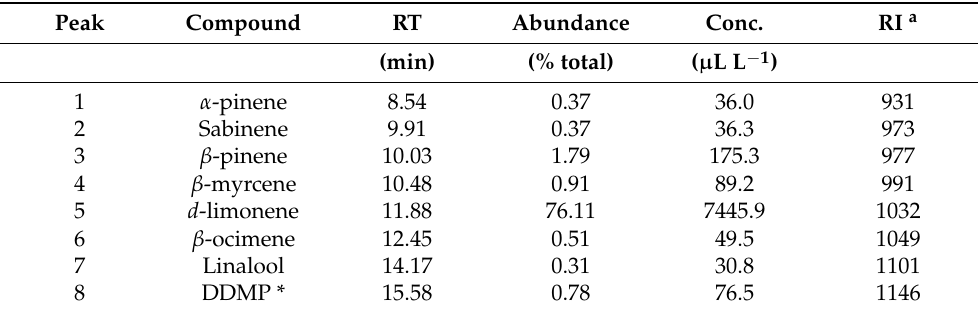
Table 1. The retention time (RT), abundance, concentration, and retention indices (RI) of the major constituents in pomelo extracts identified by GC-MS analysis.